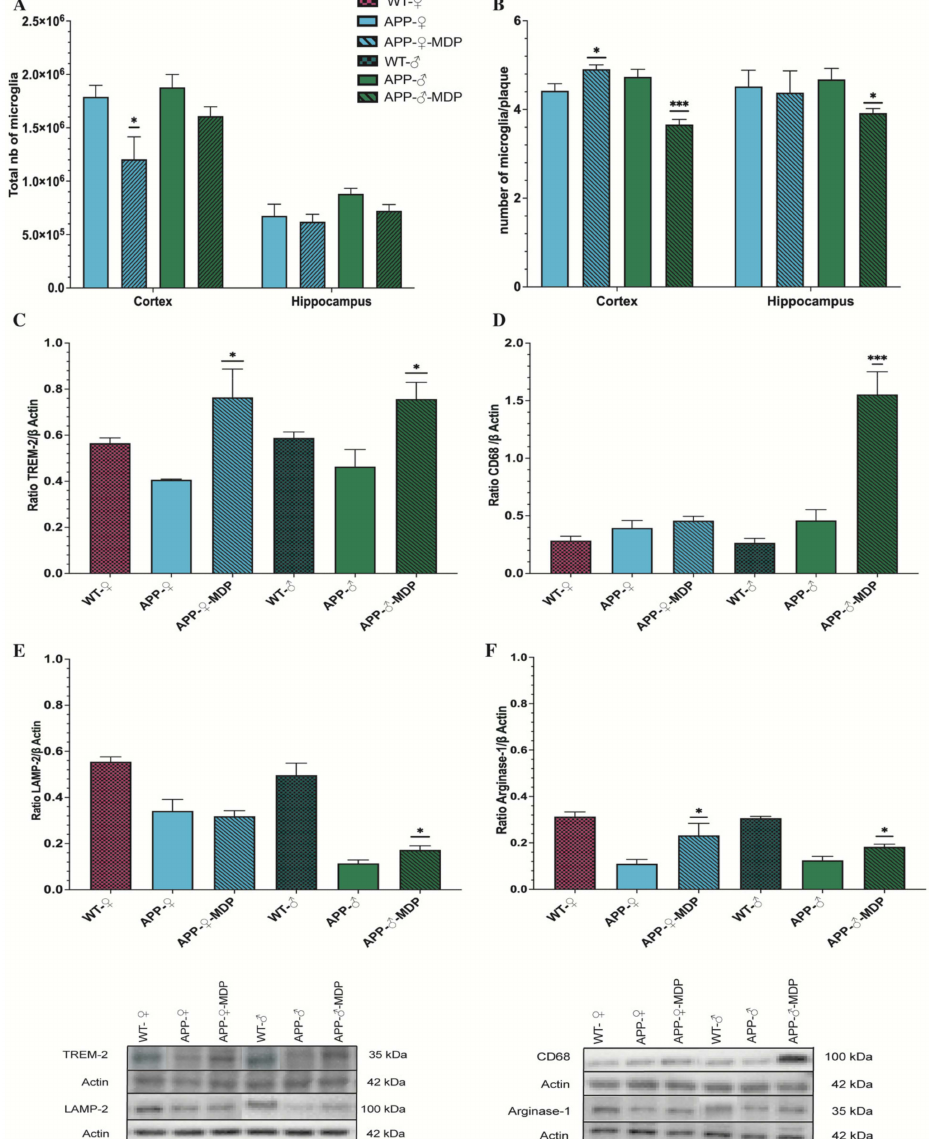
Figure 5. MDP influences the behavior of microglia in a sex-dependent manner. ( A ): Unbiased stereological analysis of the microglia (Iba-1) number in the male and female APP Swe /PS1 treatment or not with MDP groups in the hippocampus and cortex. Analysis showed no difference in the male APP Swe /PS1 treatment group in both areas; microglia are less present in the female APP Swe /PS1 treatment group in the cortex compared to the sex-matched APP Swe /PS1 controls. ( B ): Number of microglia per 6E10 + plaque of the male and female APP Swe /PS1 treatment or not with MDP groups in the hippocampus and cortex. Analysis showed a decrease in the male APP Swe /PS1 treatment group in both areas but only an augmentation for the female APP Swe /PS1 treatment group in the cortex compared to sex-matched APP Swe /PS1 controls. ( C – F ): Western blot analysis of ( C ) TREM2, ( D ) CD68, ( E ) LAMP2, and ( F ) Arginase-1 in the male or female wild-type and APP Swe /PS1 treatment or not with MDP groups. Data are mean ± SEM ( n = 8 animals/group). * p < 0.05, *** p < 0.001, compared to sex-matched APP Swe /PS1